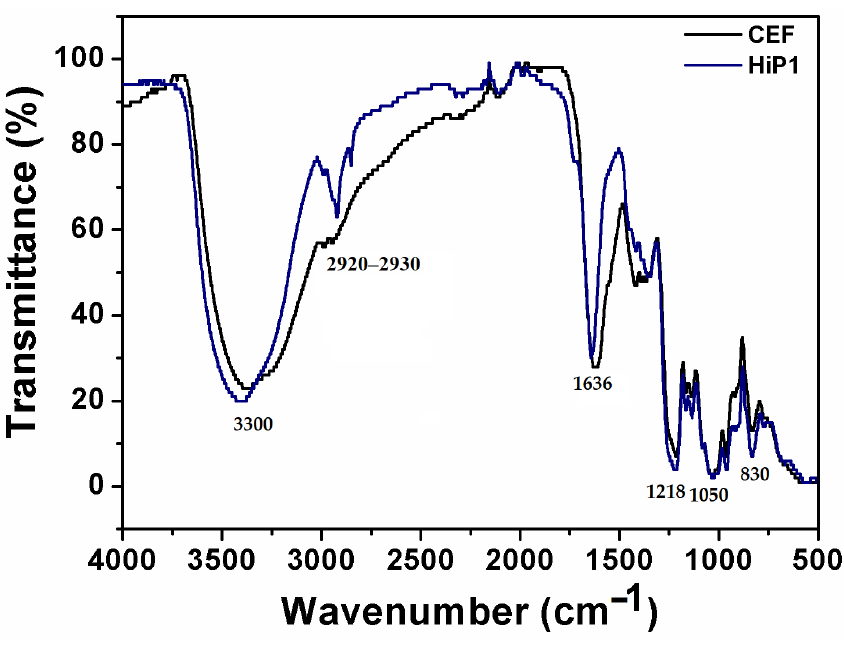
Figure 2. FTIR-ATR spectra of the type-fucoidan polysaccharide crude (CEF) and purified (HiP1) extracts from S. filipendula.